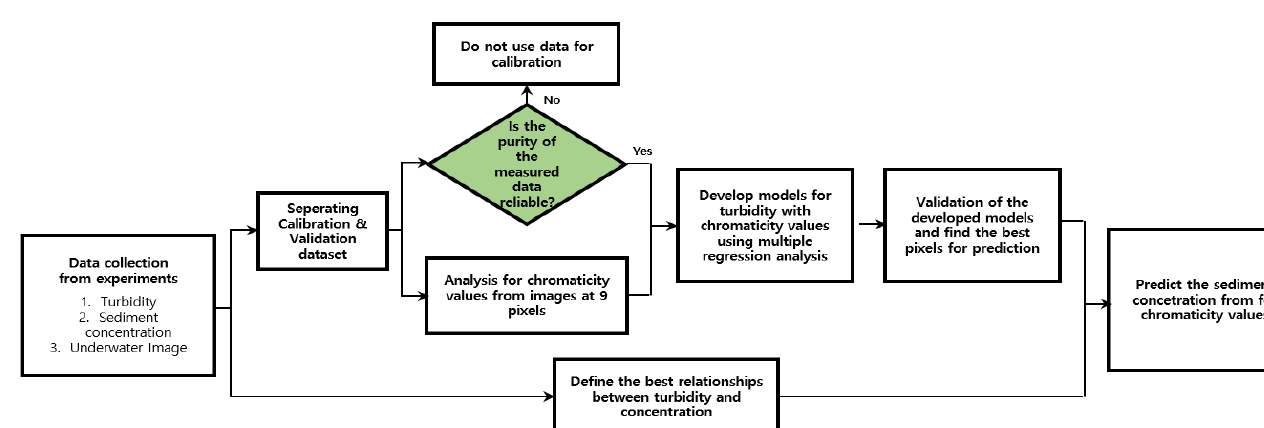
Figure 6. Flow chart of this study.